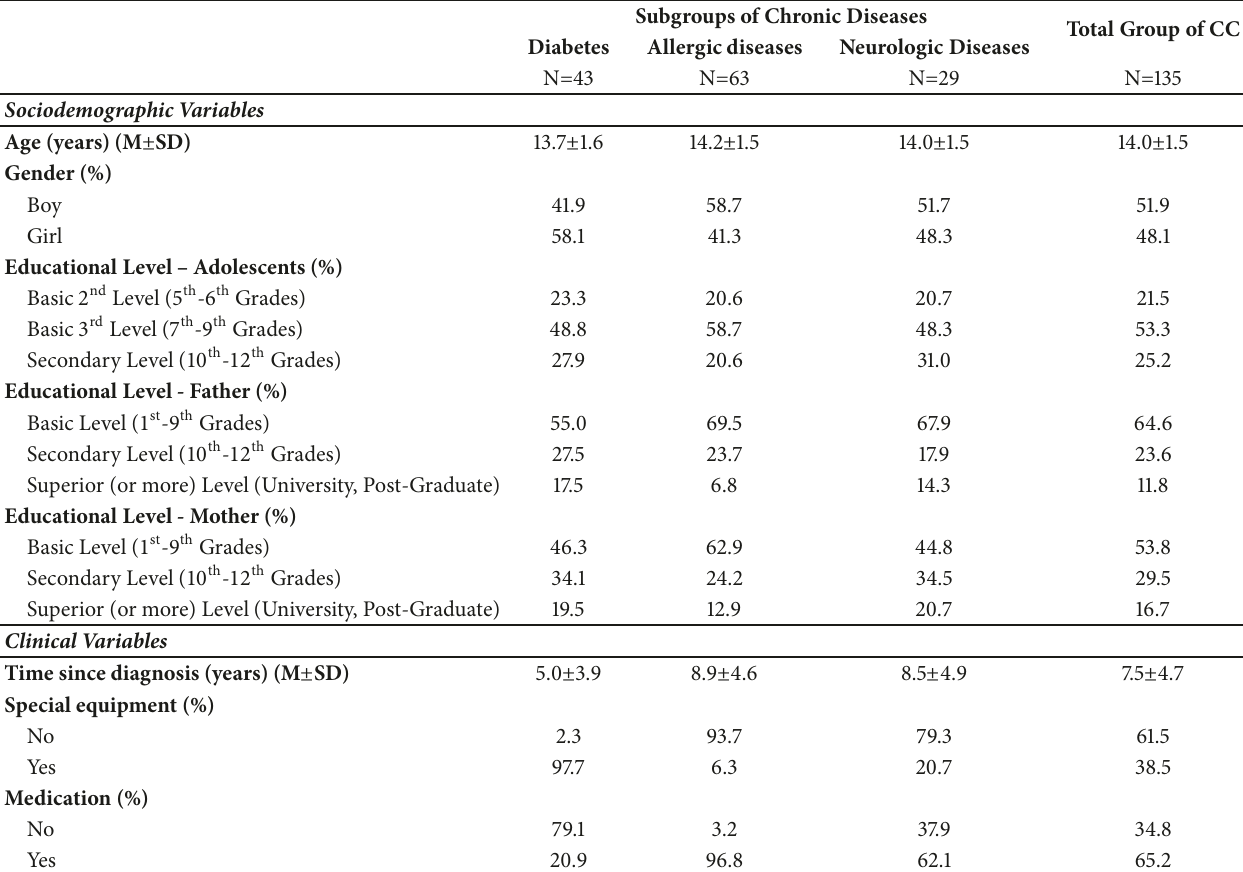
Table 2: Participants’ sociodemographic and clinical